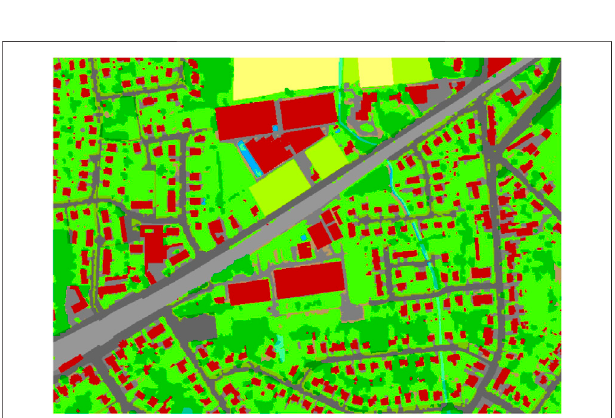
FIGURE 6 | Clustered and ribbon development in the case study region.